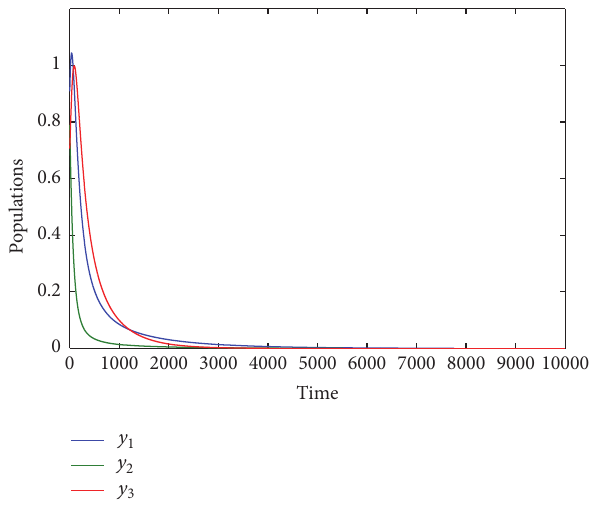
Figure 4: Time series of system (3) approaches asymptotically to the vanishing equilibrium point for 𝑏 1 = 0.15 with other parameters given by (69).